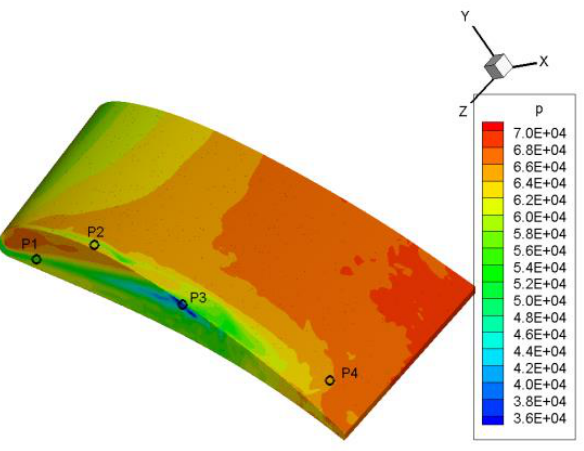
Figure 11. The positions of four different sensors on the flap side-edge